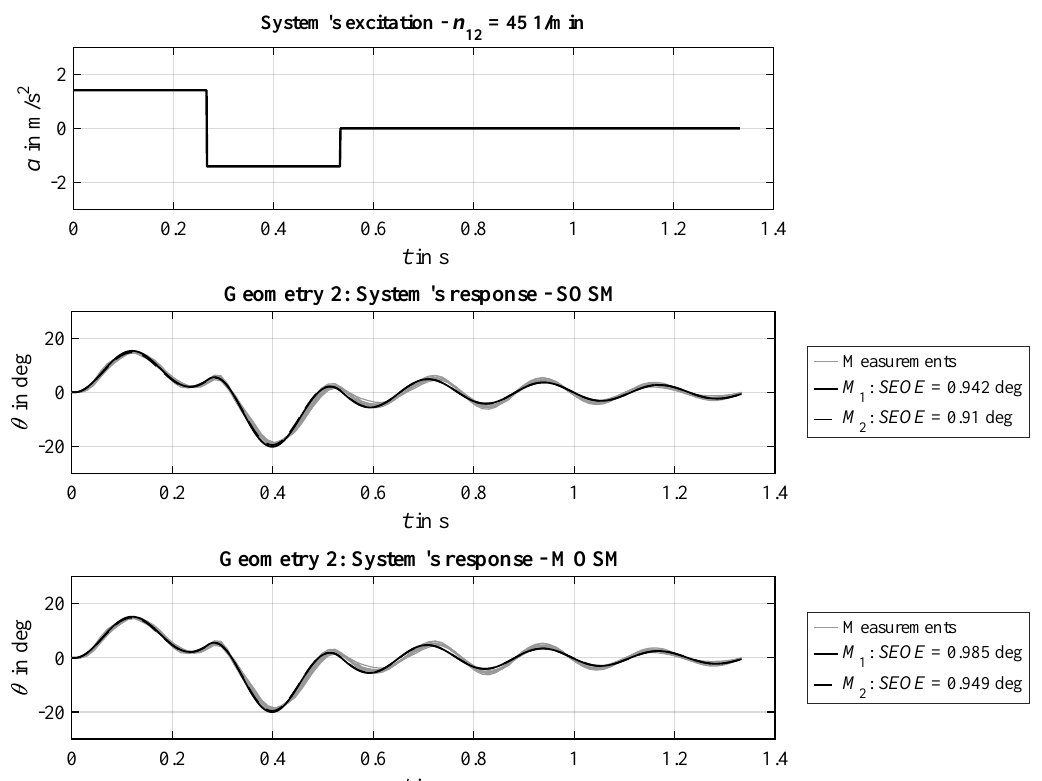
Figure 8. Exemplarily results of measured and simulated courses for all different model approaches of Geometry 2 and n = 451/min.